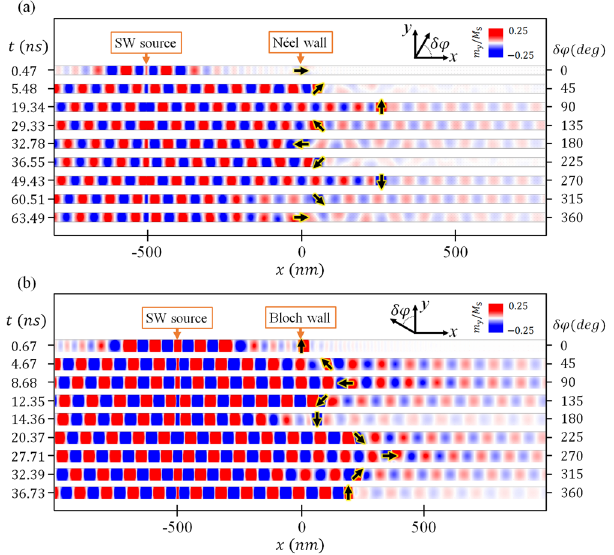
Figure 4. Time evolution of the y component of the magnetization and the DW motion in the case of ( a ) a Néel wall and ( b ) a Bloch wall for the SW with 20 GHz frequency. On the left is the simulation time of the snapshot. The black arrow indicate the orientation at the center of the DW, noted on the right.